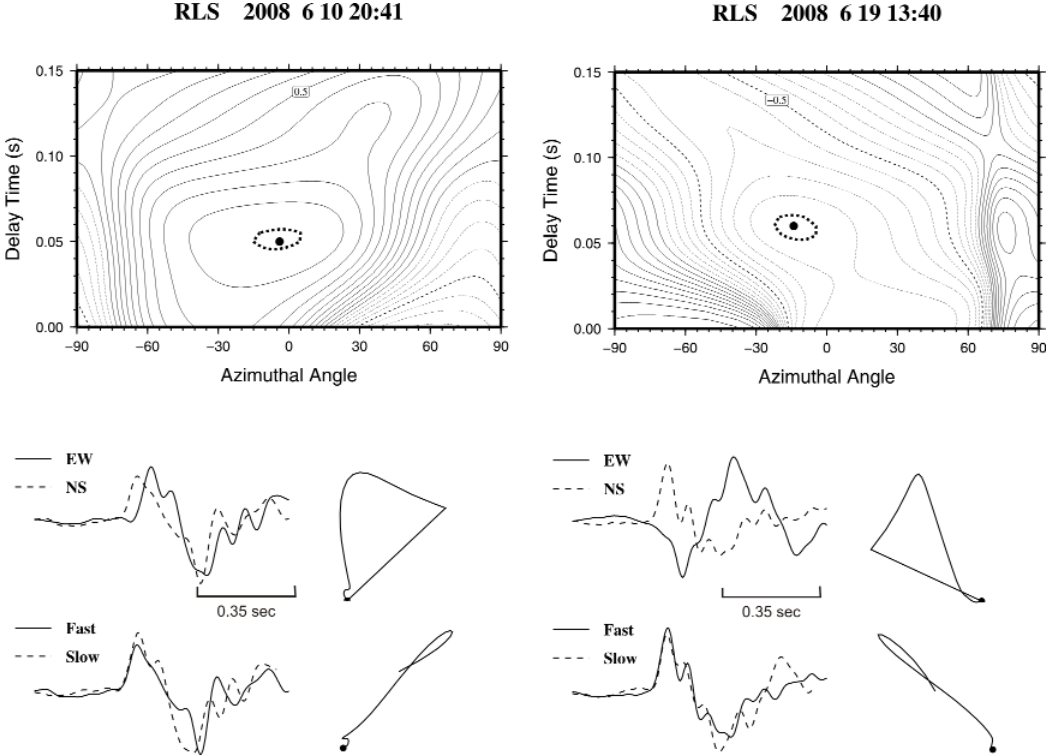
Figure 2. Valid splitting measurements of the S-waves recorded at the RLS station for two events that occurred in June 10, 2008, and June 19, 2008. Upper panel: Contour diagrams of the cross-correlation coefficients in the ( { , dt ) space. The preferred solutions ( { , dt ) corresponding to the maximum absolute values (dot) are shown within the 95% confidence region (dotted line). Lower panel: Superposition of E-W and N-S components (upper traces), and the corrected fast and slow components (lower traces). Particle motions are shown to the right of each